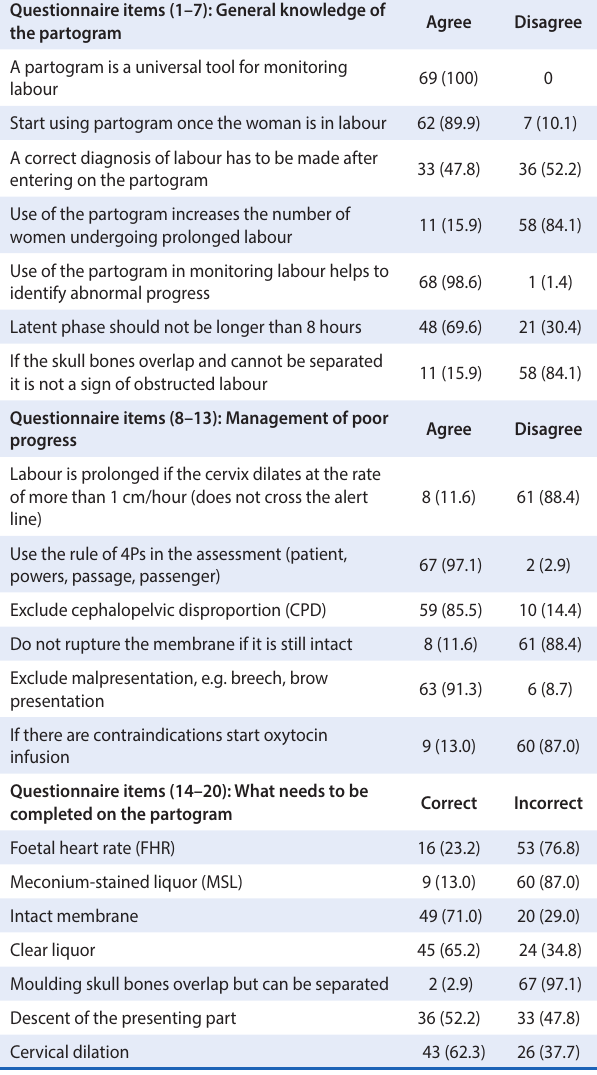
Table 2: Use of partogram amongst the doctors and midwives Questionnaire item Frequency